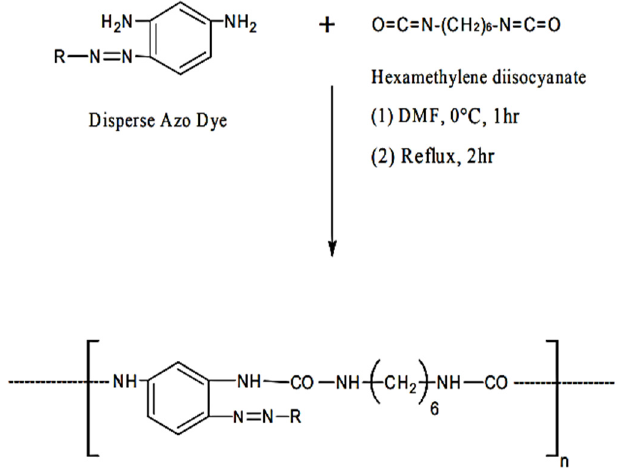
Figure 6. Synthesis of polyureas based on azo disperse dyes. From reference [19].